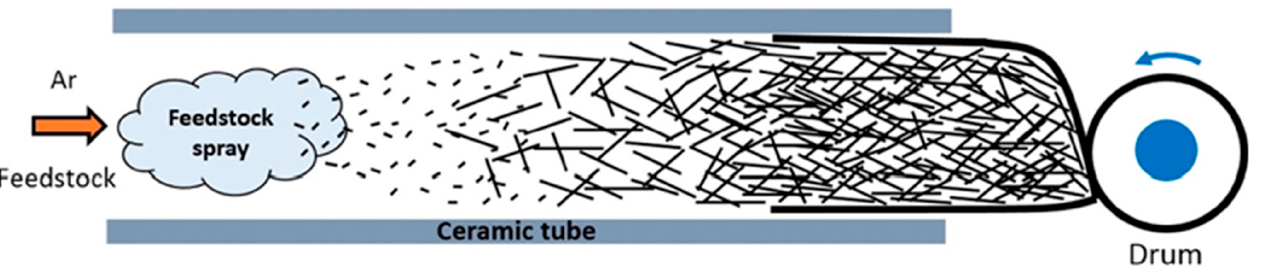
Figure 1. Custom fuel injector and particle injector attached to the inlet of the reactor.